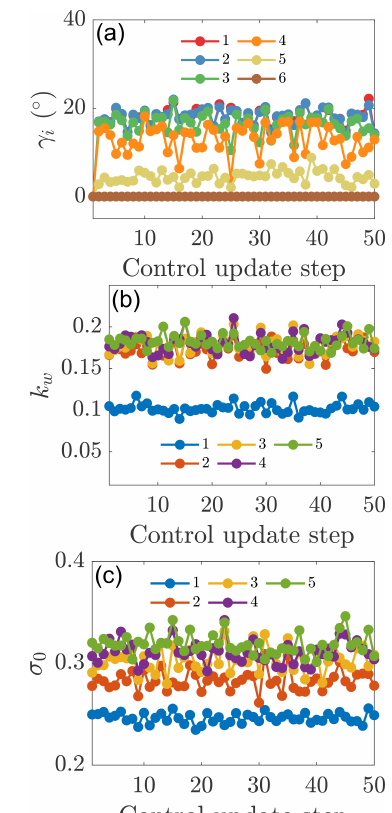
Figure D1. Wind farm (a) yaw misalignment angles, (b) k w , and (c) σ 0 as a function of the control update steps for the extended ND1